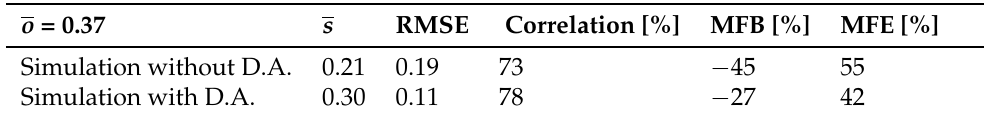
Table 4. Statistics of model to AERONET measurements comparisons for daily AOD during March 2009. s and RMSE are expressed in µ g · m − 3 . o =